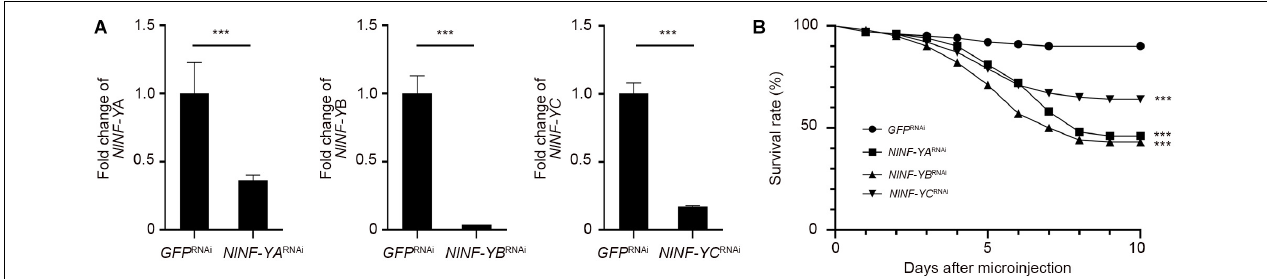
FIGURE 3 | The survival rate of BPHs after dsRNA treatment. (A) Examination of RNAi efficiency. Fifth-instar nymphs (0–24 hAE) were microinjected with dsRNAs, and BPHs ( n = 5 for each of three replicates) at 24 h after adult eclosion were collected for qPCR assay. The relative expression of NlNF-YA , NlNF-YB , and NlNF-YC was normalized to the expression of rps11 . (B) The survival rate of BPHs after dsRNA treatment. Fourth-instar nymphs ( n = 100) were microinjected with dsRNAs targeting NlNF-YA , NlNF-YB , NlNF-YC , or Gfp . Statistical analysis was performed by log-rank (Mantel-Cox) test. NlNF-YA RNAi , ds NlNF-YB RNAi , or ds NlNF-YC RNAi